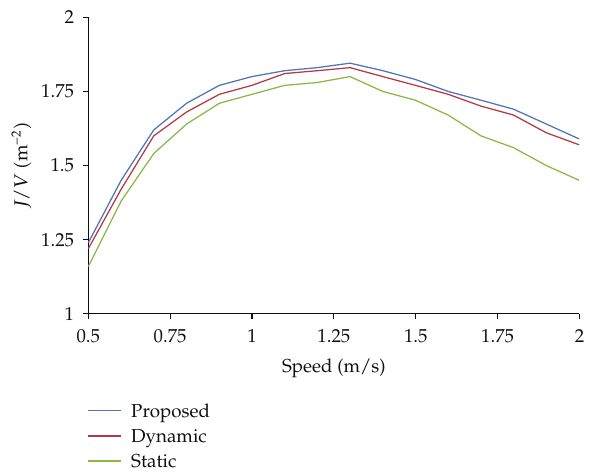
Figure 11: E ff ectiveness of evacuation, J/V , from the room in Figure 8 at di ff erent